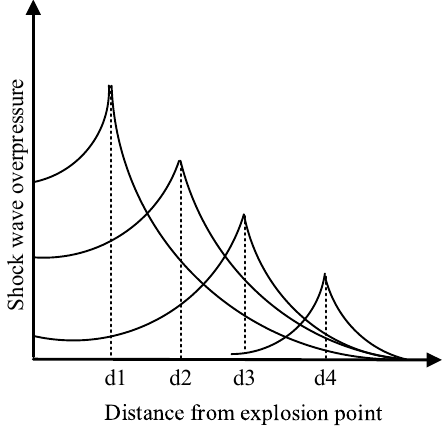
Figure 1. Explosion shock wave overpressure decays with distance.